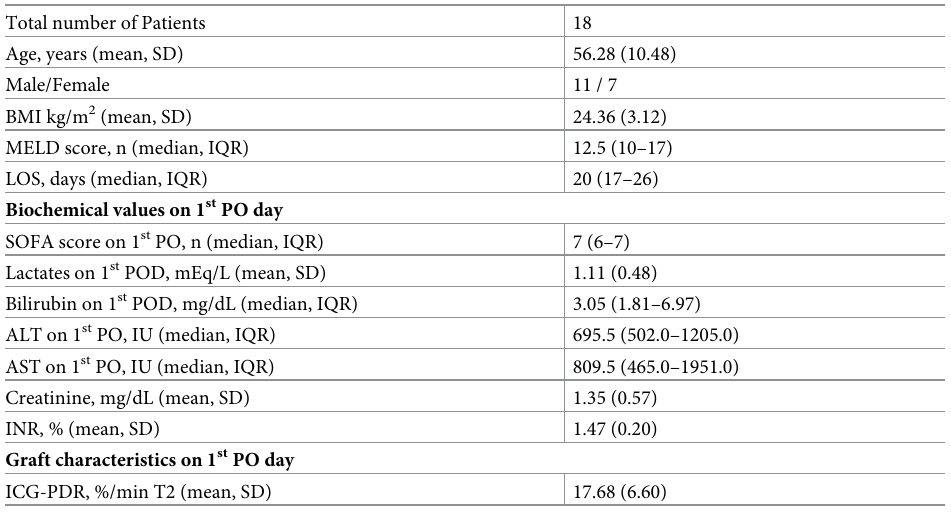
Table 2. Recipient demographical and laboratory data.